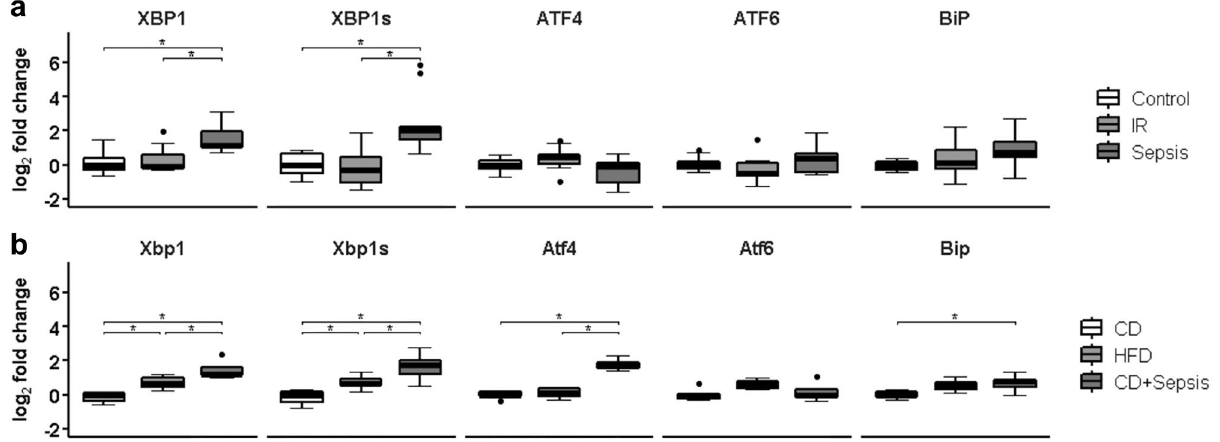
Figure 2. Gene expression analysis of indicators of UPR activation in human ( a ) and murine ( b ) skeletal muscle. Data are given as normalized log2-fold changes compared to the median of the respective control groups as reference. Plots for human data represent n = 10 of matched subjects per group (Suppl. Table 2), and plots for animal data represent n = 5–6 animals per group. ATF activated transcription factor, BiP binding protein, also known as glucose-regulated protein 78 kDa; CD control diet, HFD high-fat diet, CD control diet, HFD high-fat diet, IR insulin resistance, XBP1s X-box protein 1 spliced, XBP1 X-box protein 1; *p <